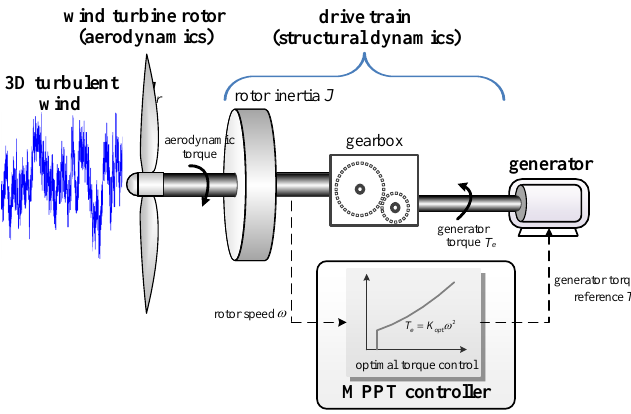
Figure 2. A closed-loop model of variable-speed wind turbines (VSWTs).